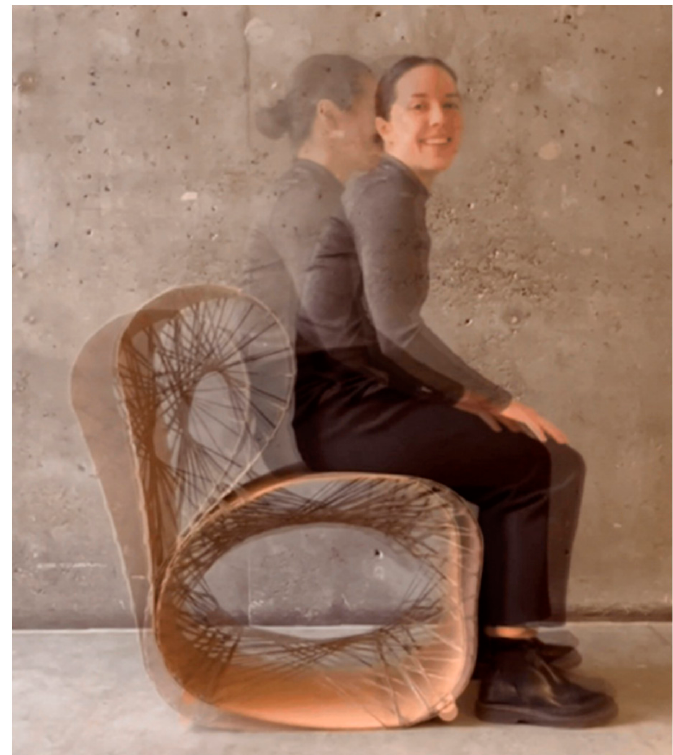
Figure 19. Final rocking chair prototype.